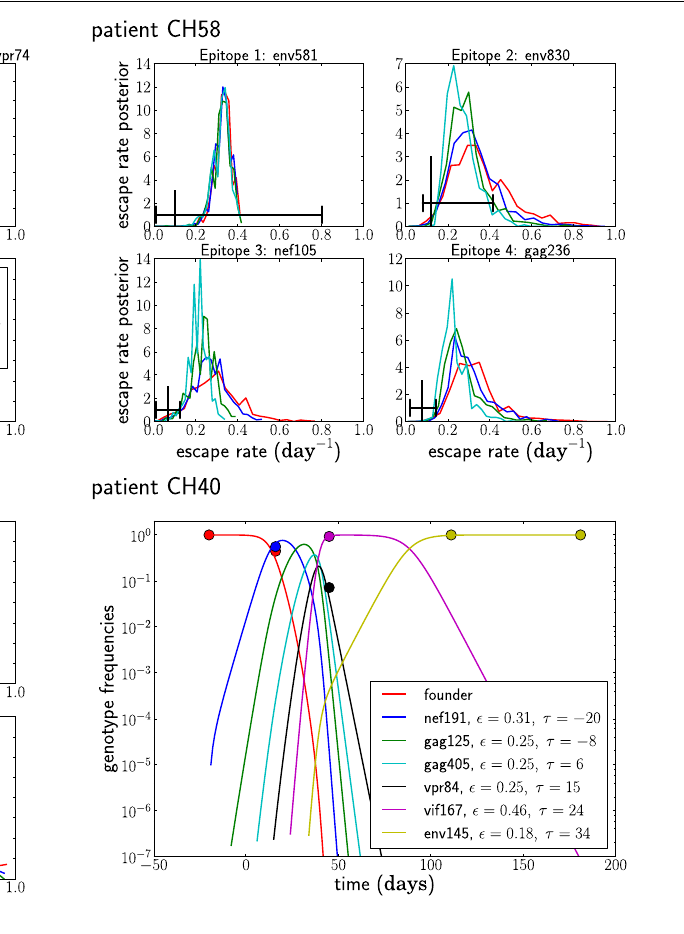
FIGURE 8 |The posterior distribution of the escape rates for different population sizes . It is assumed that CTL selection starts 20days prior to the date of identification, and the fitness prior has weight Φ = 10.The black vertical and horizontal lines indicate the estimates and confidence intervals obtained in Ganusov et al. (4). Note that the mutation env145 in CH40 was not analyzed in Ganusov et al. (4).The lower right panel shows the most likely